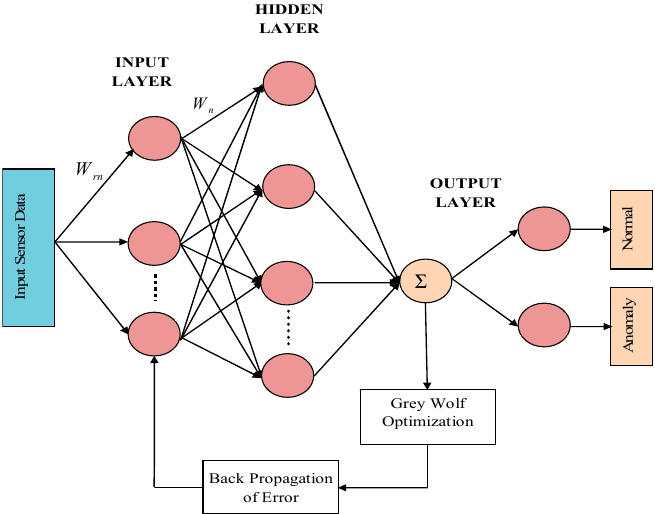
Figure 2. The structure of the proposed gray wolf optimization (GWO)-based modified artificial neural network (ANN).